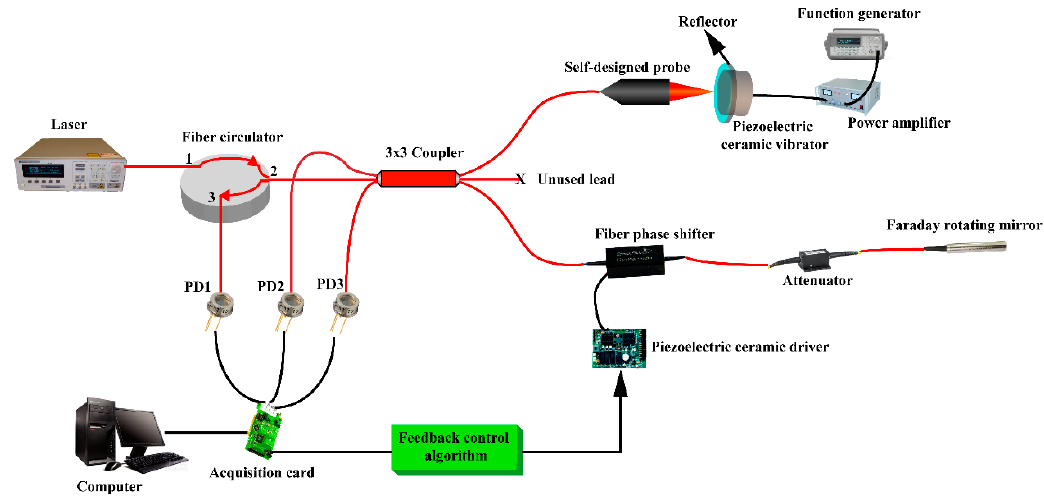
Figure 3. The experimental interferometer system.